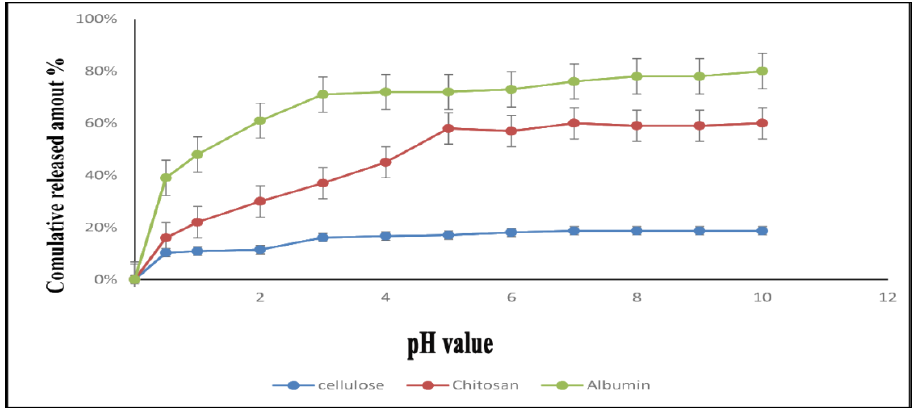
Figure 2. In vitro drug release study of carnosic acid from albumin, chitosan, and cellulose NPs at three pH values. Medium 1 (pH 1.5) for two hours, then medium 2 (pH 7.2) for 6 h, and finally medium 3 (pH 7.9) for 2 h.